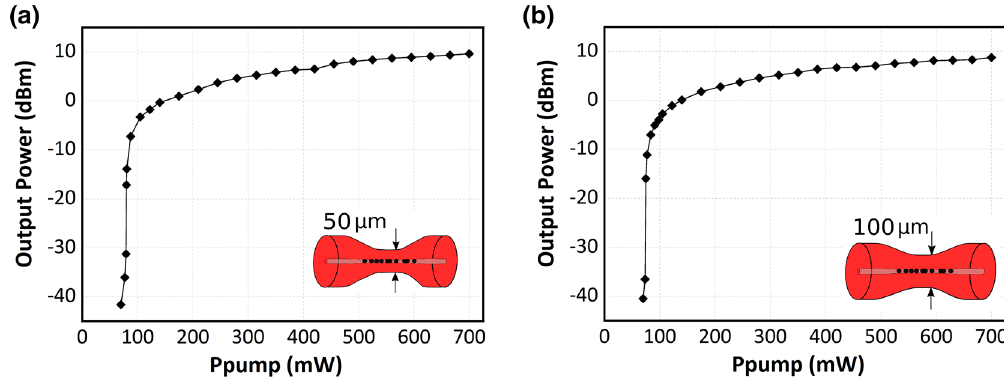
Figure 7. ( a ) Relationship between the output-power values as a function of 976-nm pump power for the 50 µm-waist MDTF-based fiber laser. ( b ) Relationship between the output-power values as a function of 976-nm pump power for the 100 µm-waist MDTF-based fiber laser.